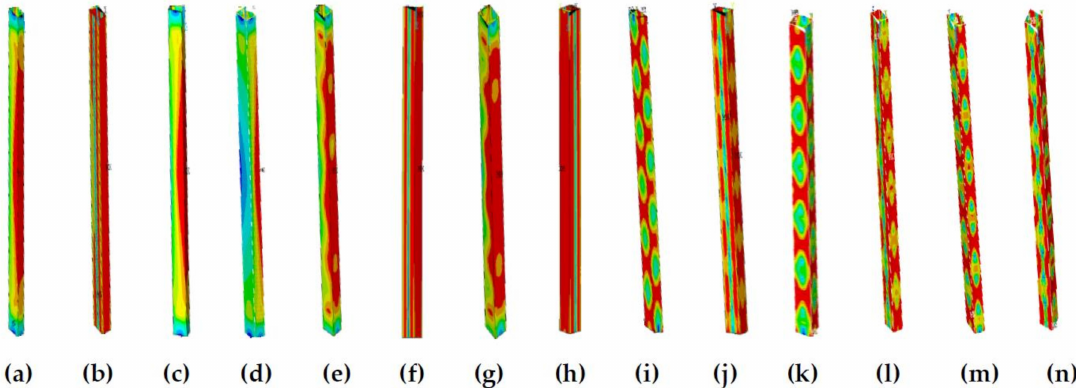
Figure 16. The buckling equivalent stress cloud diagram when λ = 30. ( a ) b / t = 10, ( c ), b / t = 15, ( e ) b / t = 20, ( g ) b / t = 25, ( i ) b / t = 35, ( k ) b / t = 40, and ( m ) b / t = 50 without residual stress; ( b ) b / t = 10, ( d ) b / t = 15, ( f ) b / t = 20, ( h ) b / t = 25, ( j ) b / t = 35, ( l ) b / t = 40, and ( n ) b / t = 50 with residual